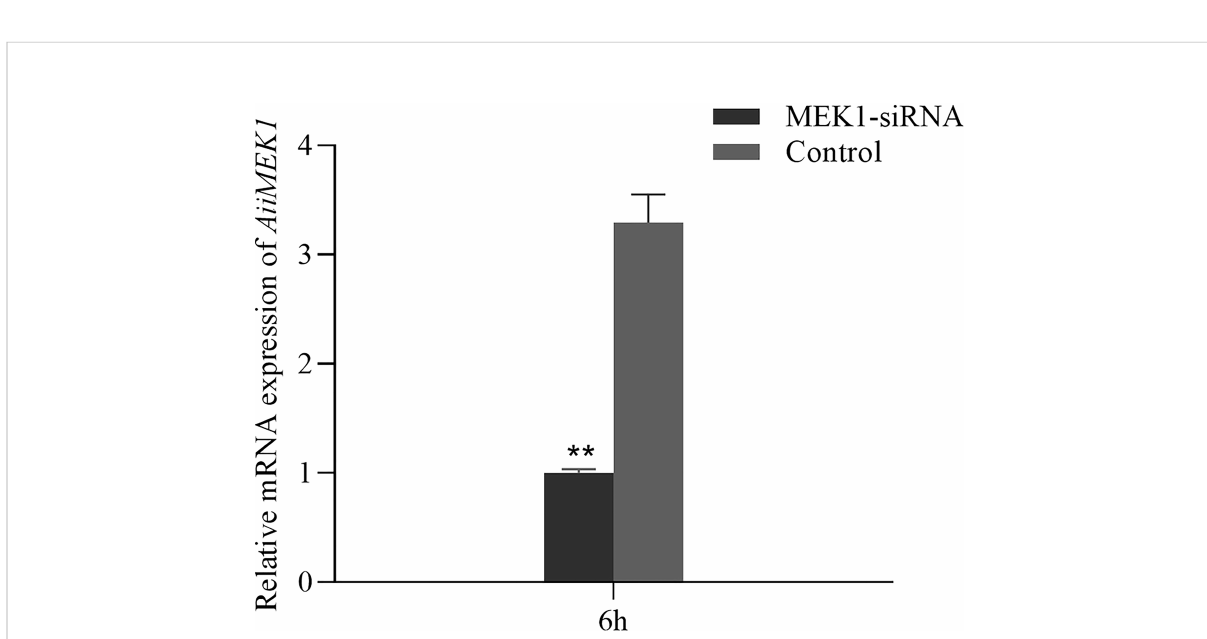
FIGURE 9 Relative expression of MEK1 in the hepatopancreas of A. irradians after RNAi (** p <